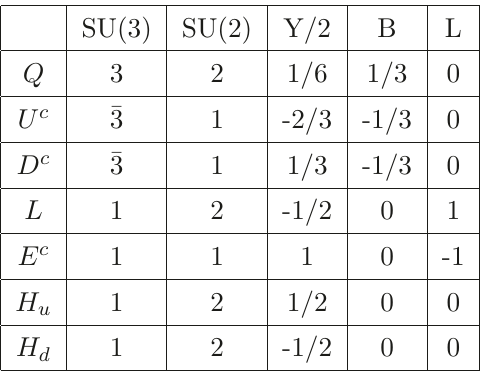
Table 1 . MSSM matter superfields and their gauge, B and L